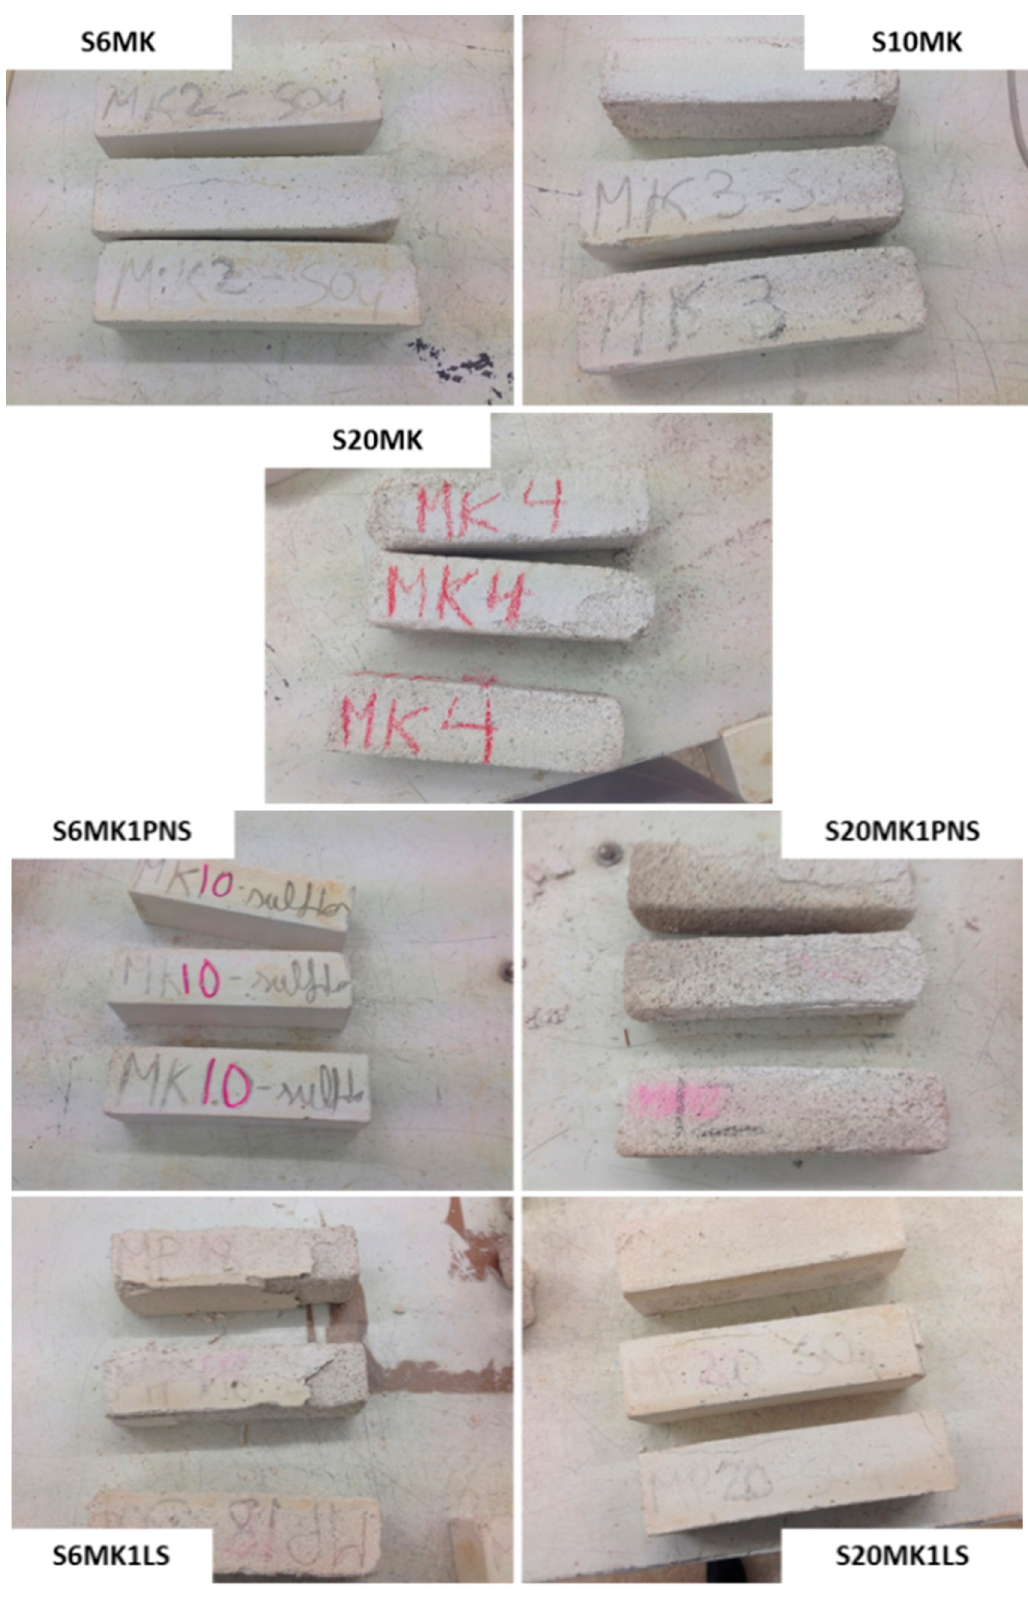
Figure 14. Appearance of different grouts after five sulphate crystallization cycles.